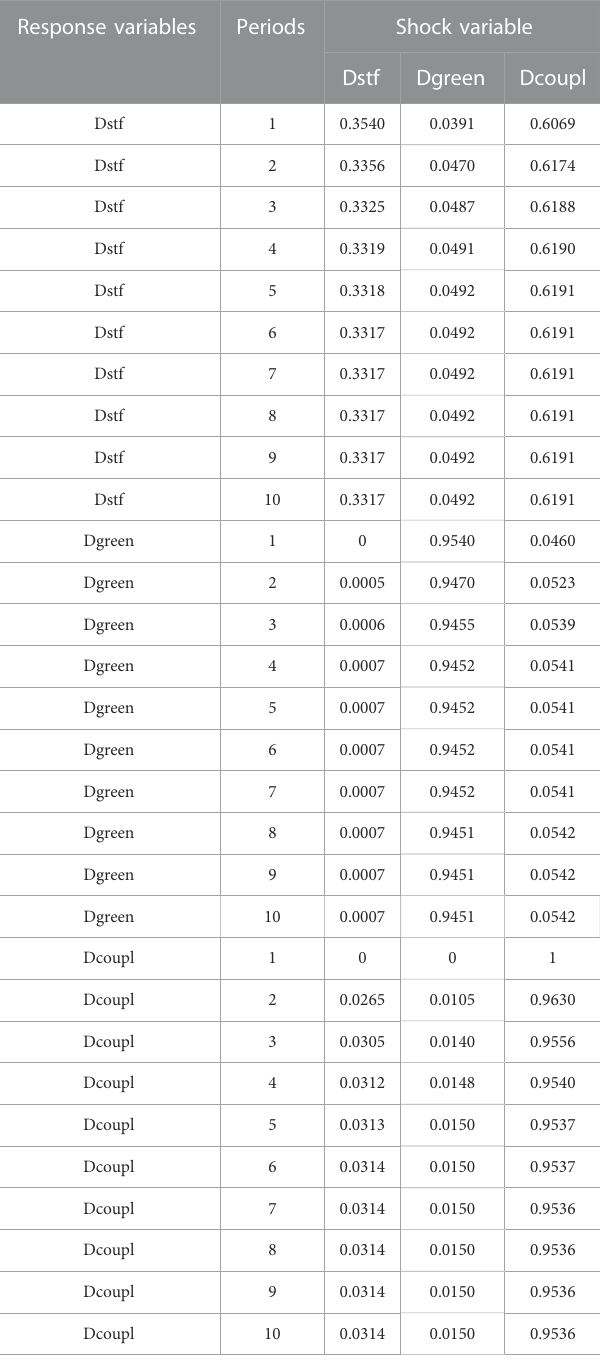
TABLE 11 Variance decomposition